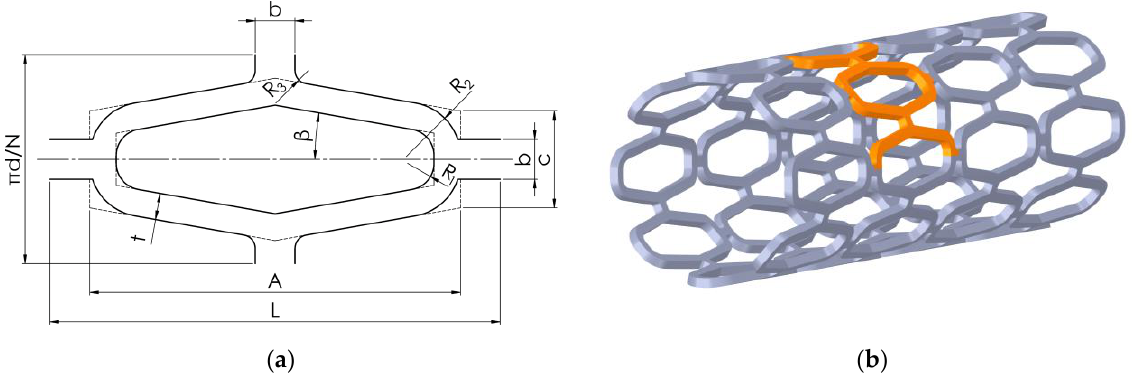
Figure 1. Stent shape: ( a ) Unit cell shape and dimensions; ( b ) full stent with highlighted area for simulation (orange). Table 1. Stent dimensions.